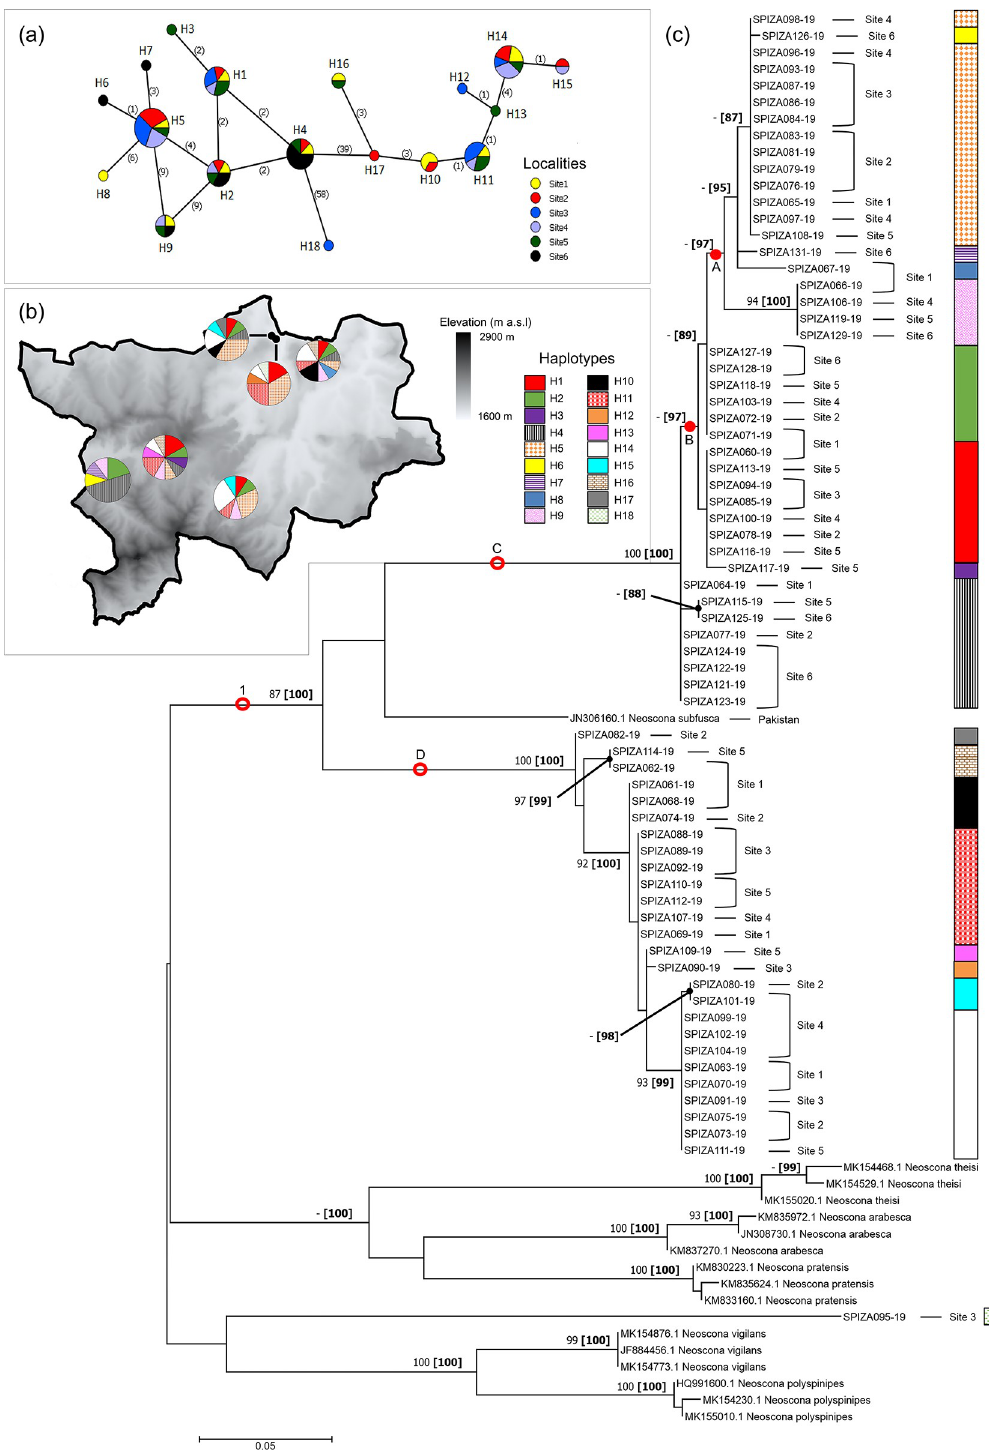
Fig 3. Haplotype networks and phylogram of Neoscona subfusca populations of the Golden Gate Highlands National Park, based on a portion of mt DNA COI gene. (a) Minimum Spanning Network (MSN) connecting sampled sequences through putative mutational steps according to geographical locality of populations. Circles represent defined haplotypes, while circle diameters are proportional to frequency. Numbers in parentheses correspond to mutational steps. (b) Distribution of defined haplotypes within sampled localities. (c) Phylogenetic tree based on Maximum Likelihood (ML)